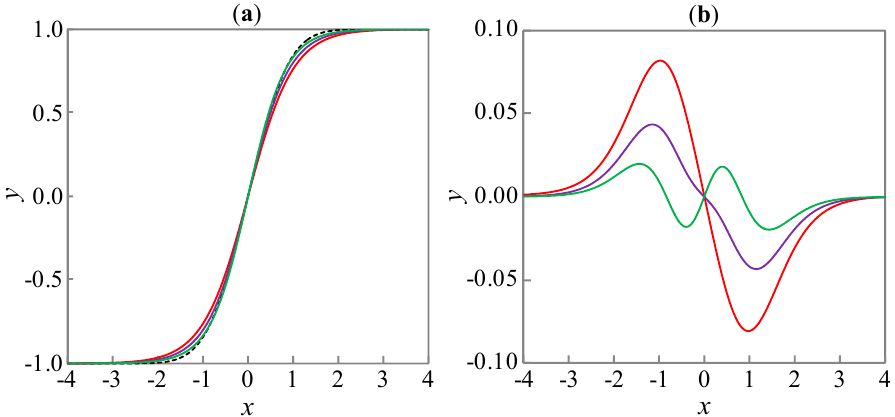
Figure 3. Function curve plots of ( a ): y = erf( x ) (dashed), y = tanh( ρ x ) (solid), and ( b ): y = tanh( ρ x ) − erf( x ). The coefficient ρ is set to 1.0 (red), 1.1 (purple), and 1.2 (green).